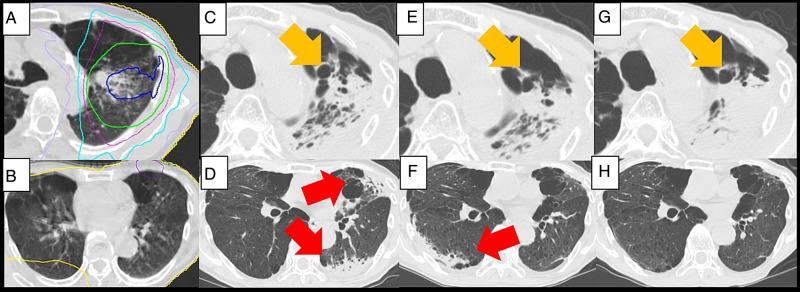
Chest CT and dose distribution of stereotactic body radiotherapy (SBRT) of a 70-year-old male patient. Dose distribution of SBRT. Isodose lines of 60 Gy (blue), 50 Gy (green), 40 Gy (purple), 30 Gy (light blue), 20 Gy (lavender) and 0.5 Gy (yellow) (A, B). Radiation pneumonitis (RP) represents in high-dose irradiated area (C, orange arrow) and patchy opacity in left lung appeared 6 months after SBRT (D, red arrow). No significant change in RP 9 months after SBRT (E, orange arrow). The radiographic lesion in the left lung disappeared and a new lesion in the right lung appeared. (F, red arrow). These radiographic changes were considered to be the sequential change of organizing pneumonia (OP) (migration). RP resulted in fibrosis (G, orange arrow), and OP resolved without fibrosis at 12 months after SBRT (H).